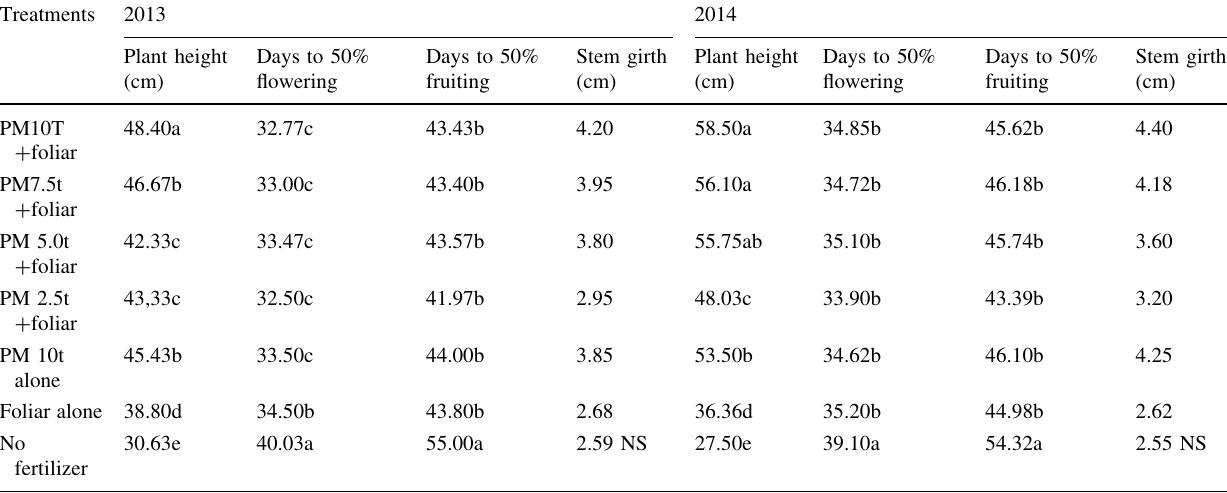
Table 3 Growth of okra as affected by the combined application poultry manure and foliar fertilizer in 2013 and 2014 cropping seasons Treatments